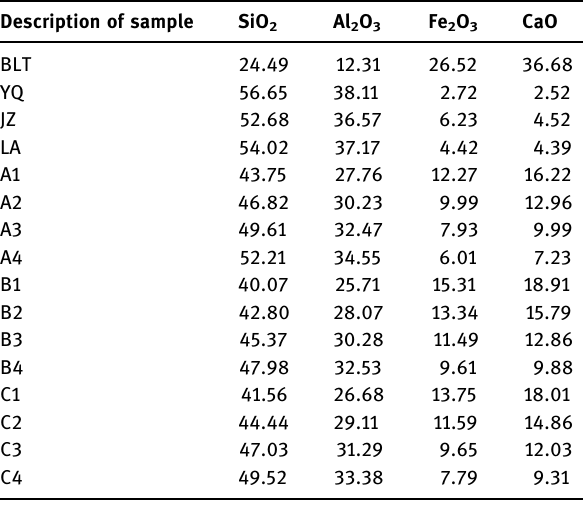
Table 4: The main oxide content in ash of single coal and blended coal,